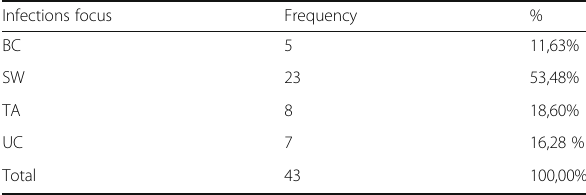
Table 1 (abstract 0158). The most frequent infection focus founded Infections focus